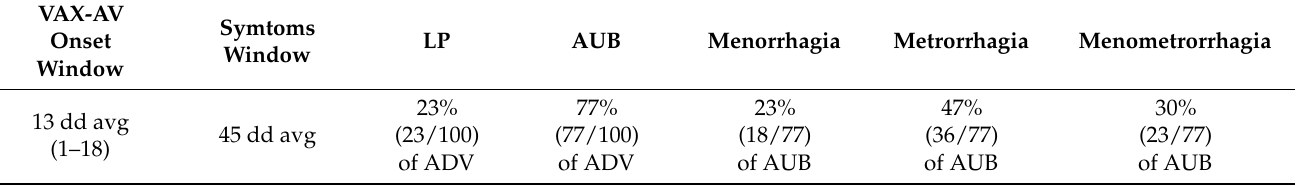
Table 1. Adverse effects-group (ADV) characteristics and variables (expressed in percentage, %).